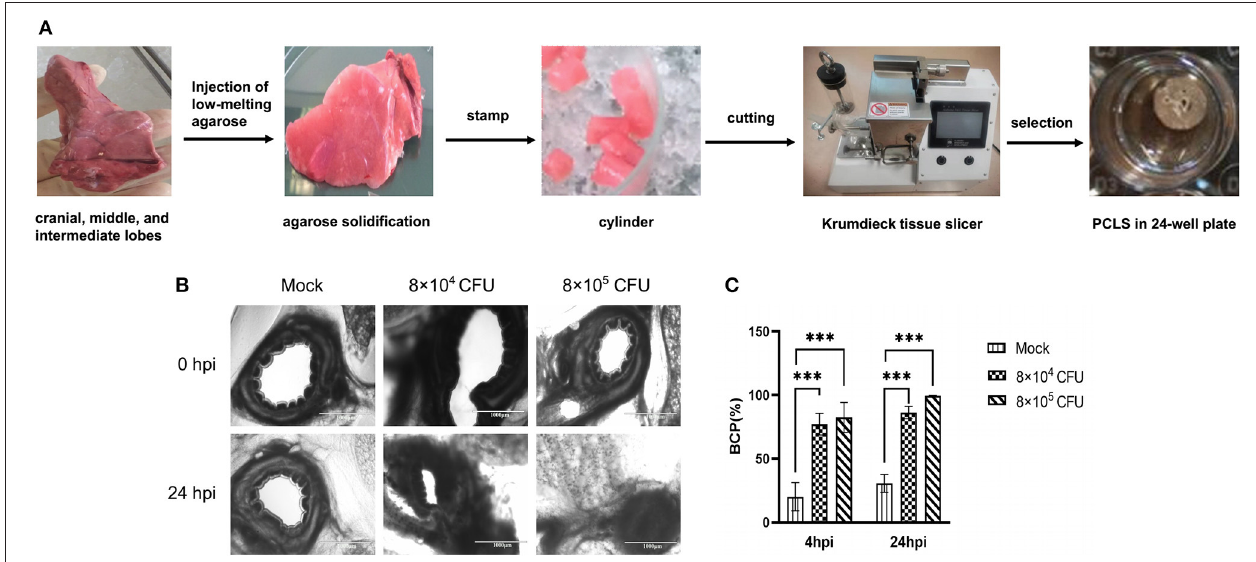
FIGURE 5 | T. pyogenes 20121 induced bronchoconstriction in porcine PCLS cultures. (A) The PCLS preparation process; (B) Light microscope imaging of bronchial cavities in infected (8 × 10 4 or 8 × 10 5 CFU) and mock PCLS cultures at 4 and 24 hpi; (C) Bronchial cavity area was measured and calculated as bronchial contraction percentage (BCP). Results are expressed as means ± S.D., and significance was determined using two-way ANOVA and the Tukey multiple-comparison test. *** p < 0.001.